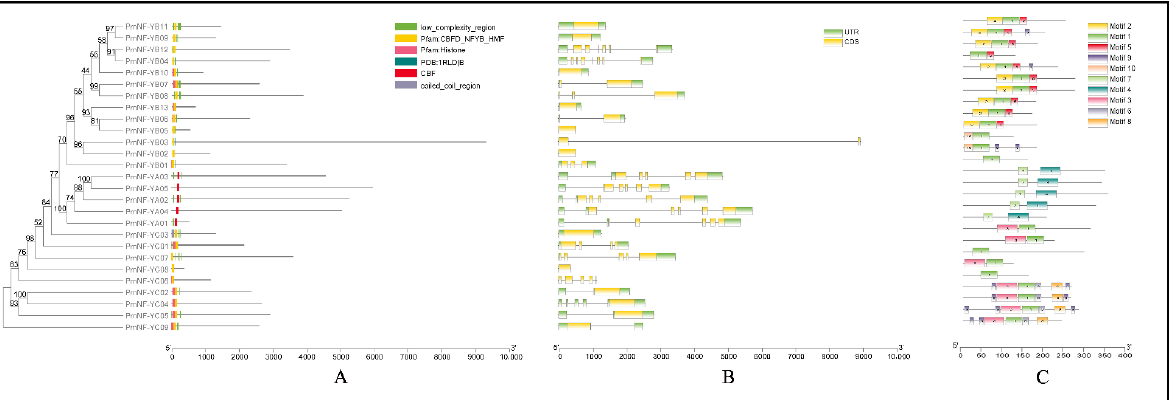
Figure 2. The protein conserved domains, gene structures, and conserved motifs of PmNF-Y genes based on phylogenetic relationships. ( A ) Distribution of protein conserved domains. ( B ) The PmNF-Y gene structures. ( C ) The PmNF-Y gene conserved motifs.